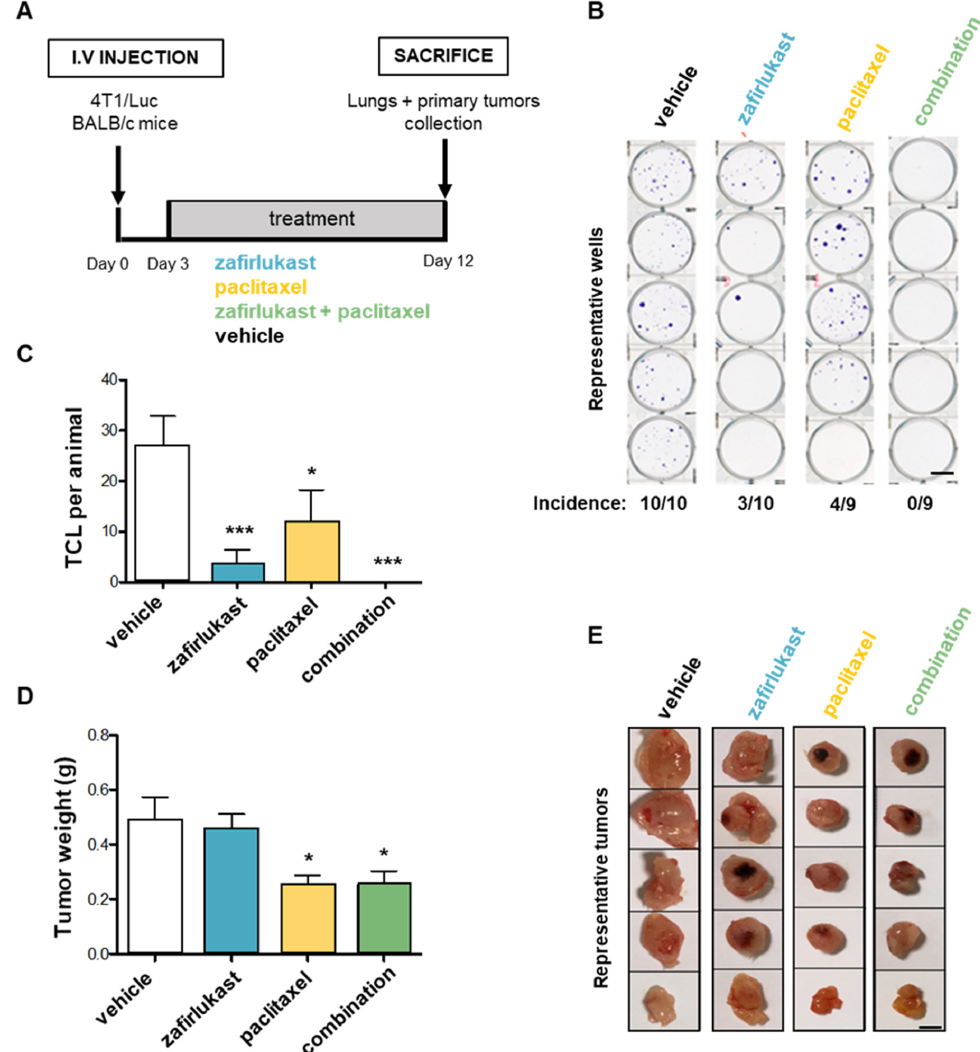
Figure 7. Blockade of CysLT1R with zafirlukast prevents spontaneous lung colonization by 4T1 cells without affecting orthotopic tumor growth in a syngeneic mouse model. ( A ) Murine 4T1 breast cancer cells were injected in the mammary gland of BALB/c mice that were treated with zafirlukast (0.4 mg/kg/day, i.p), paclitaxel (30 mg/kg/2 days), a combination of both drugs, or the vehicle. After 14 days, lungs and primary tumors were collected. Vehicle = physiological serum. ( B ) Lungs were minced and treated with collagenase and cultured for 14 days with 6-thioguanine (1 µ g/mL). Tumor cells that colonized the lungs (TCL) were fixed and stained by crystal violet (scale: 100 µ m). ( C ) TCL were quantified. ( D ) Mammary tumors were collected and weighed. ( E ) Primary tumors were classified by size. The data represent the mean ± SD (vehicle and zafirlukast: 10 mice; paclitaxel and combination: 9 mice). * p < 0.05; *** p < 0.001 vs. vehicle; Mann–Whitney